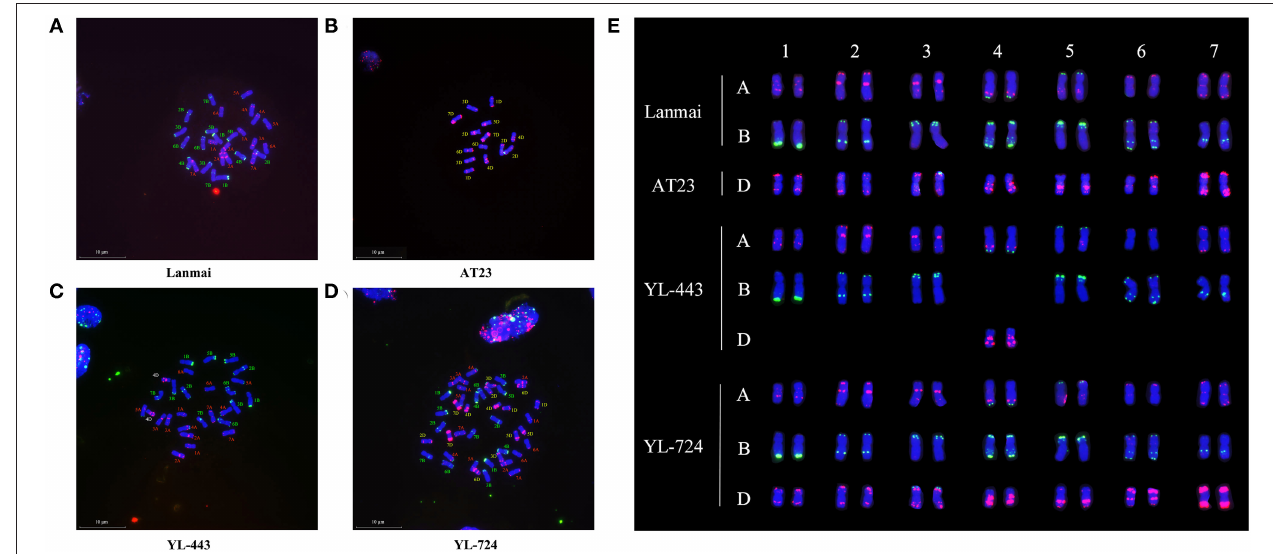
FIGURE 2 | The mc-FISH karyotypes of Lanmai, AT23, YL-443, and YL-724 hybridized with probes Oligo-pSc119.2 (green) and Oligo-pTa535 (red). (A) Durum wheat Lanmai; (B) Ae. tauschii AT23; (C) Lanmai 4D(4B) disomic substitution line YL-443; (D) Lanmai/AT23 amphiploid line YL-724; (E) Comparison of chromosome constitution of all lines through cutting out